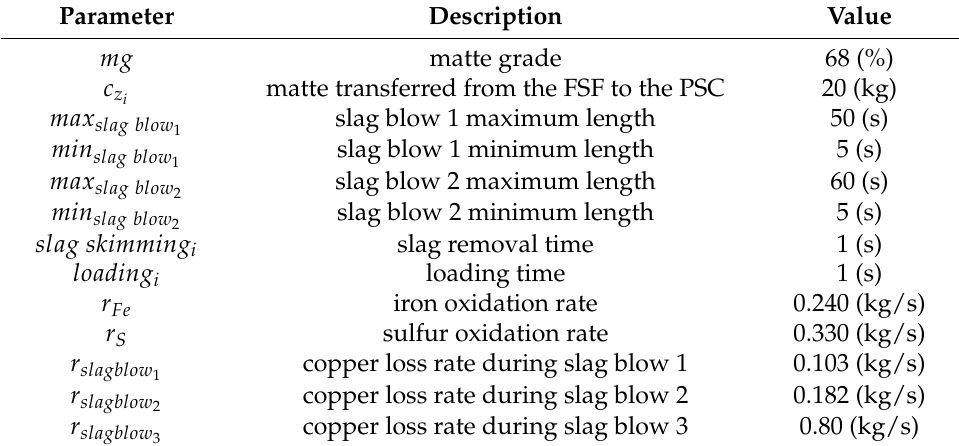
Table 1. Framework